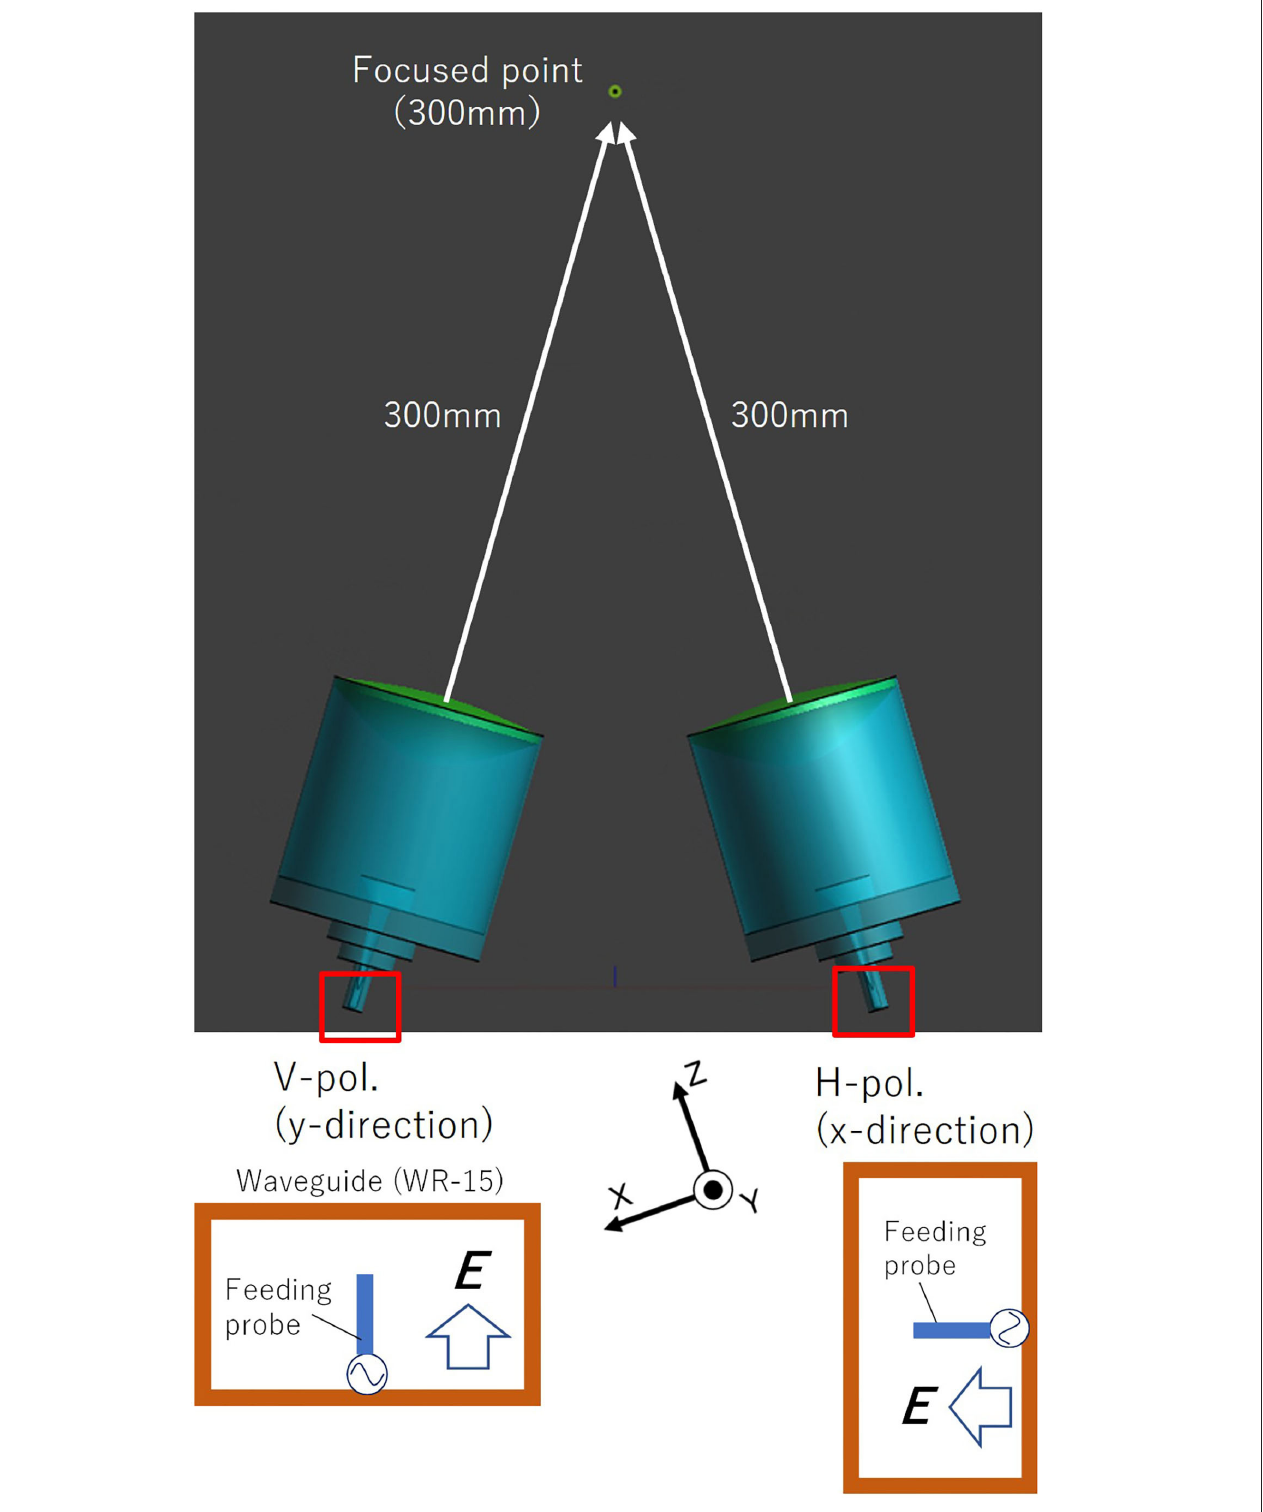
FIGURE 3 | Orthogonal polarized feeding for spatial synthetic